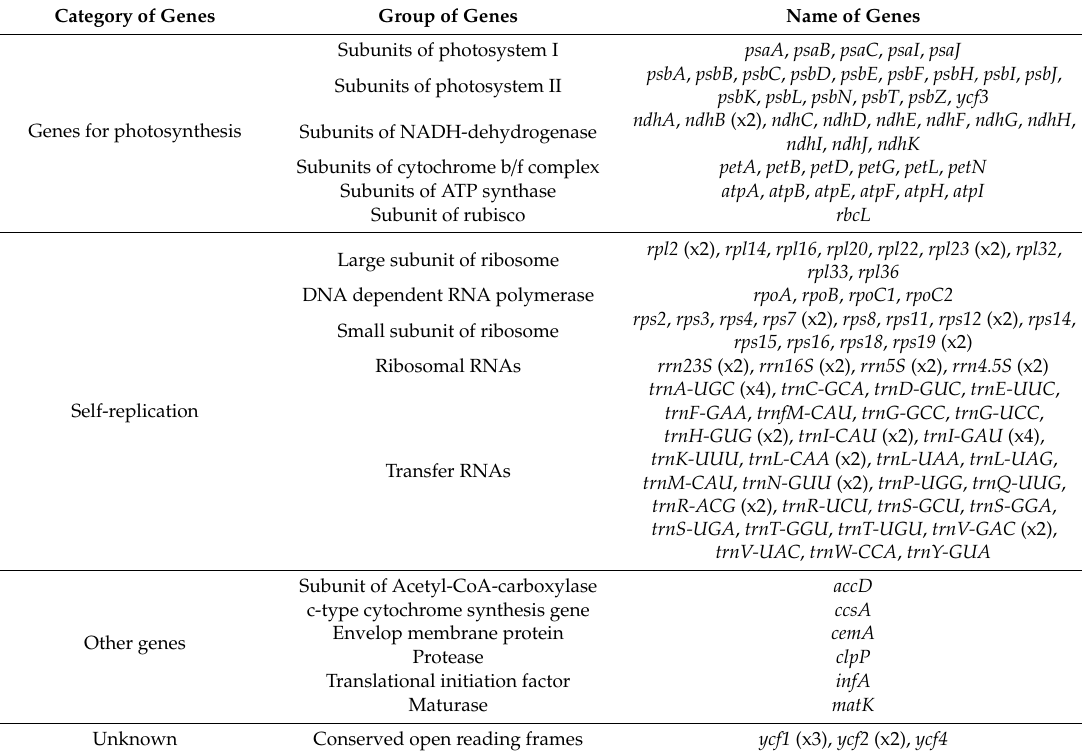
Table 2. Gene composition of seven Lycoris chloroplast